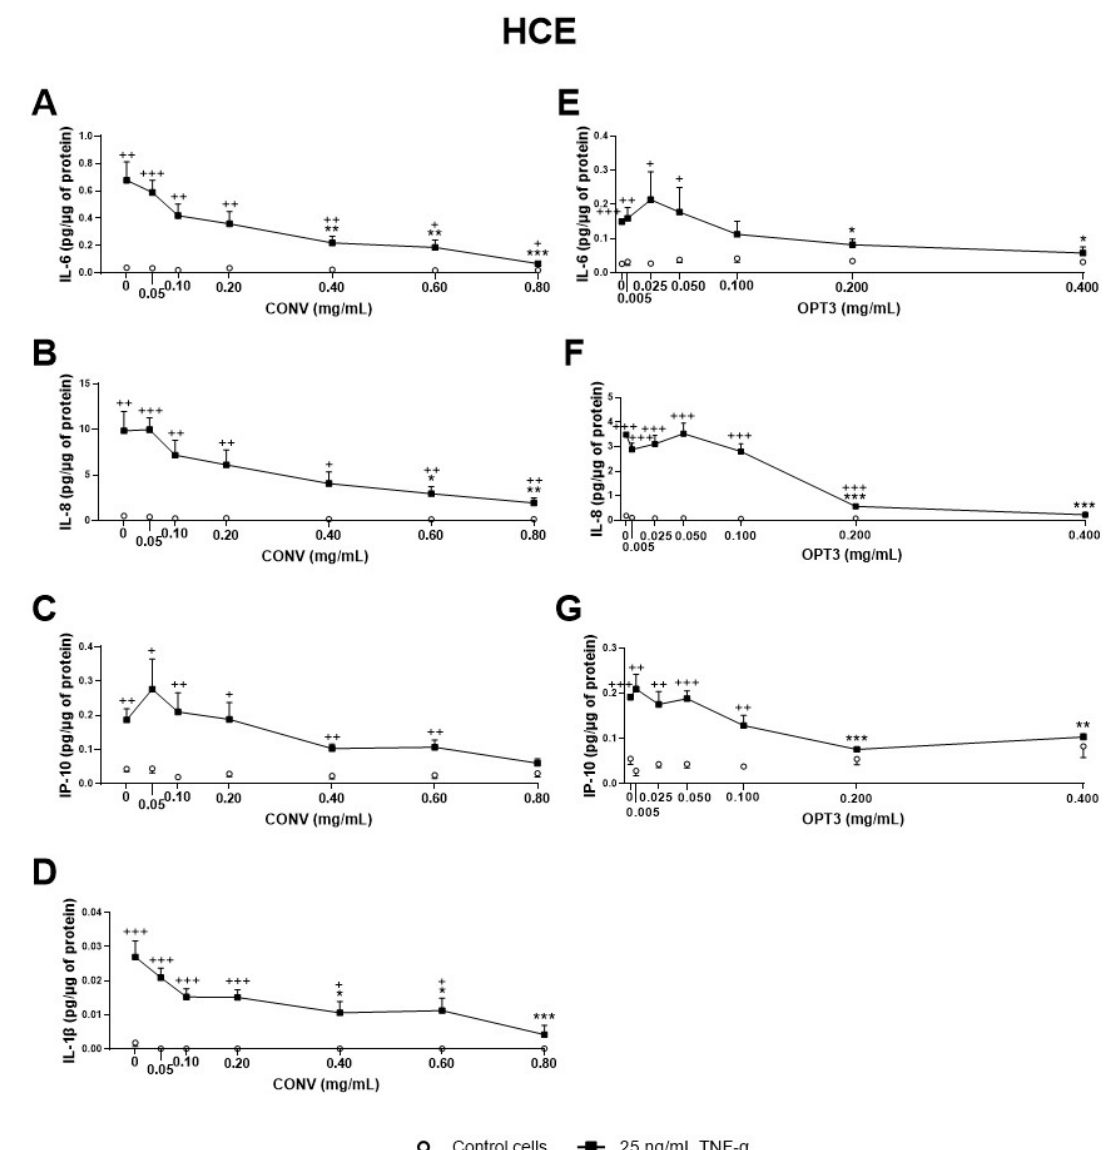
Figure 3. Effect of the conventional (CONV) and the selected optimized (OPT3) olive pomace (OP) extracts on TNF- α - induced cytokine release by HCE cells. Cells were pre-treated with CONV (0.05, 0.10, 0.20, 0.40, 0.60, and 0.80 mg/mL), OPT3 (0.005, 0.025, 0.050, 0.100, 0.200, and 0.400 mg/mL), or vehicle (0.4% ethanol) for 2 h. Following this, they were stimulated with 25 ng/mL TNF- α in the presence of the treatments for 24 h (black squares). Vehicle-treated-TNF- α stimulated cells and cells not stimulated with TNF- α (white circles) were used as control. IL-6, IL-8, IP-10, and IL-1 β were measured in cell supernatants by a multiplex bead-based array. TNF- α failed to stimulate IL-1 β in the experiment performed for OPT3. CONV significantly decreased IL-6 levels from 0.40 mg/mL ( A ), IL-8 levels from 0.60 mg/mL ( B ), and IL-1 β levels from 0.40 mg/mL ( D ). For TNF- α stimulated cells, IP-10 production was not decreased significantly by CONV. Nevertheless, no significant differences were observed between stimulated and non-stimulated cells at 0.80 mg/mL ( C ). OPT3 inhibited IL-6 ( E ), IL-8 ( F ), and IP-10 ( G ) secretion from 0.200 mg/mL significantly. Data are presented as picograms (pg) of cytokine/chemokine per micrograms ( µ g) of total protein for three independent experiments (performed in duplicate) ± SEM. * p < 0.05, ** p < 0.01, *** p < 0.001, compared with vehicle-treated-TNF- α stimulated cells; + p < 0.05, ++ p < 0.01, +++ p < 0.001, compared with control cells.